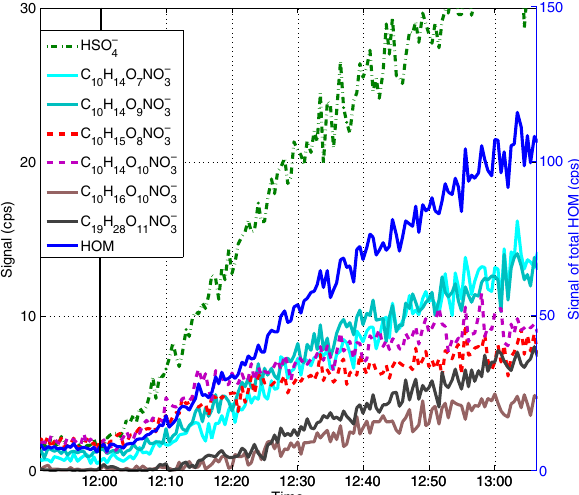
Figure 2. Example of the size distribution (2–40nm, measured by NAIS) of neutral particles (a) and the concentrations of sulfuric acid, HOM and α -pinene (b) during an ozonolysis experiment in the CLOUD chamber.